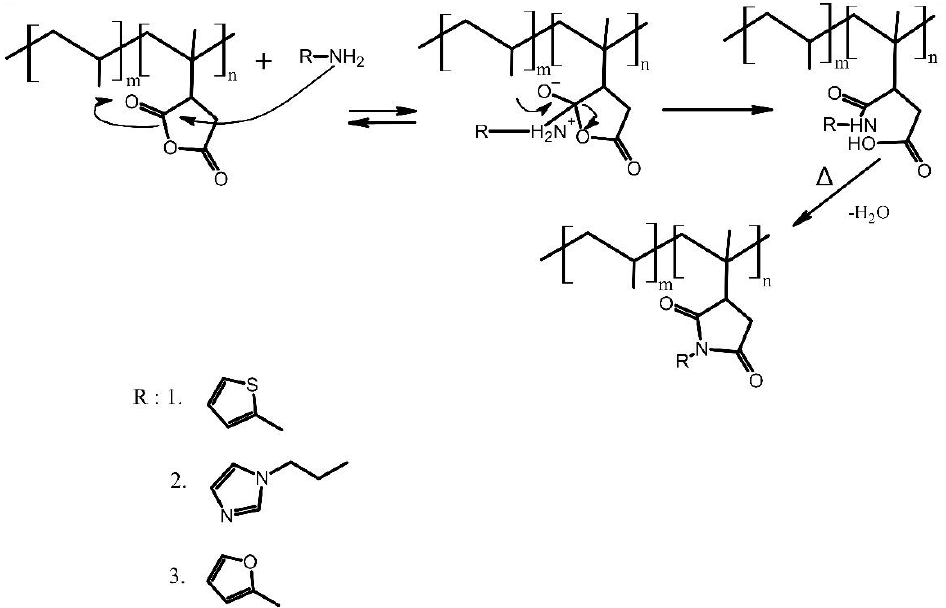
a % grafted = mol N in the grafted products/mol MA in maleated PP. b The remaining composition is assumed to consist Table 2. Elemental analysis on maleated PP and the grafted products. N% C% % Grafted a PPgMA 81.93